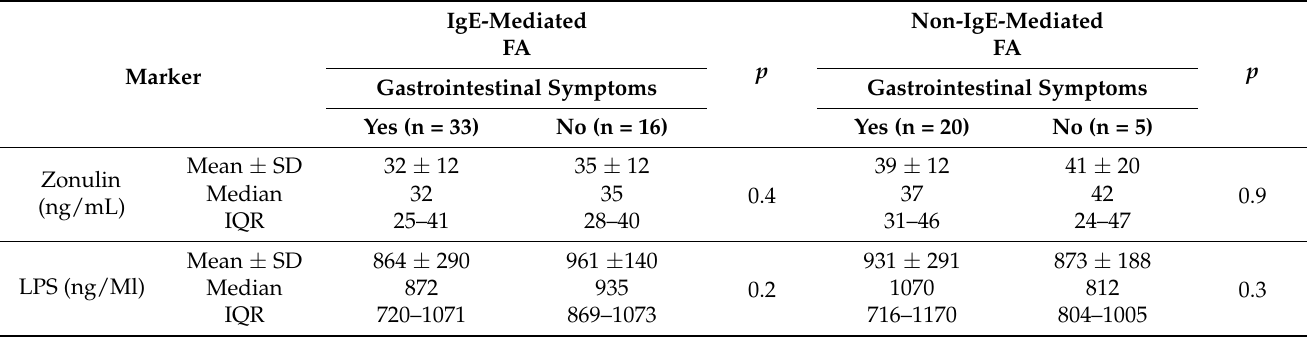
Table 3. Levels of selected IP markers in children with IgE-mediated and non-IgE-mediated FA and different clinical